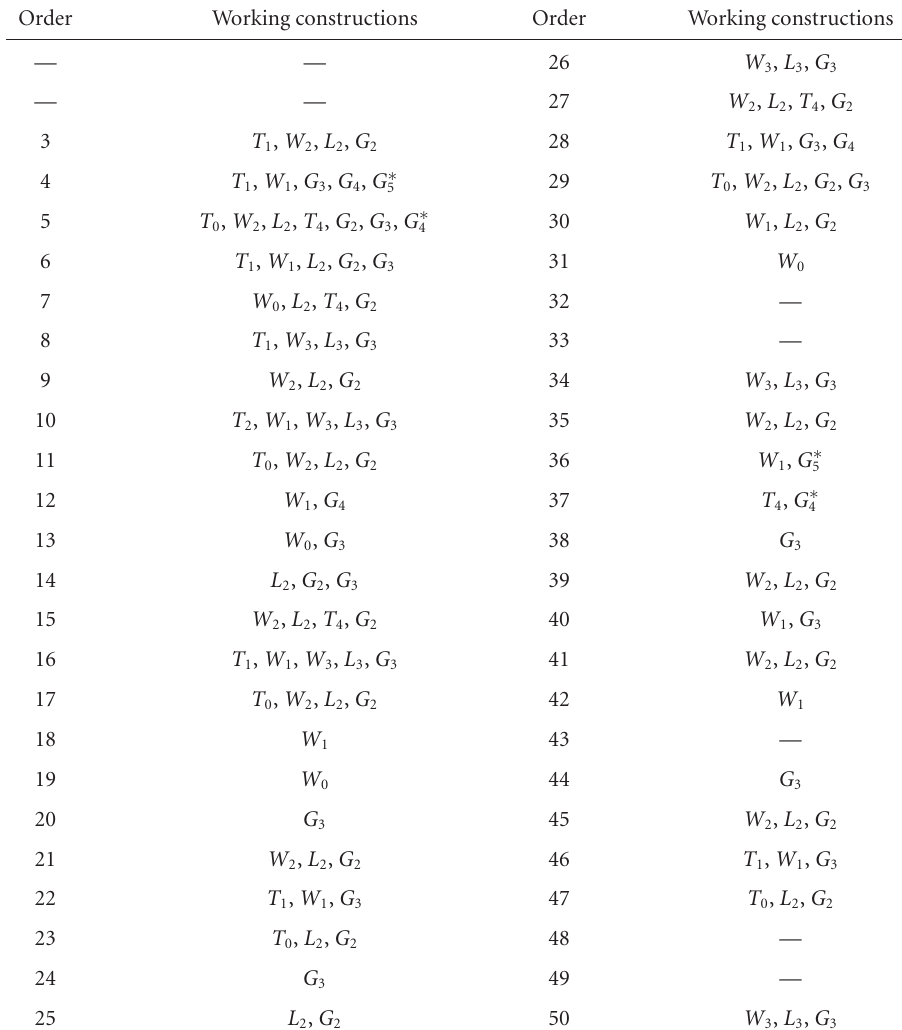
Table 9.1. Constructions that successfully produce Costas arrays for order ≤ 50 (copied from [12]). Order Working constructions Order Working